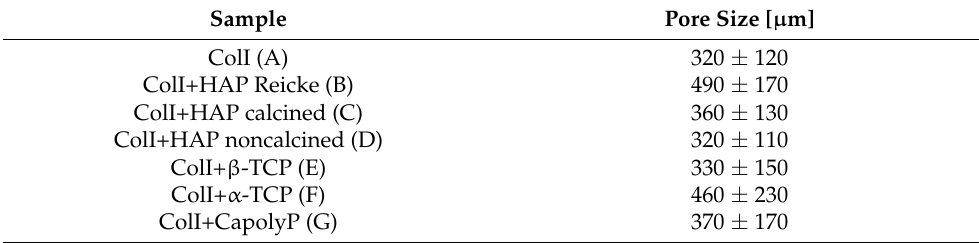
Table 1. Pore size of prepared scaffolds measured by ImageJ software.